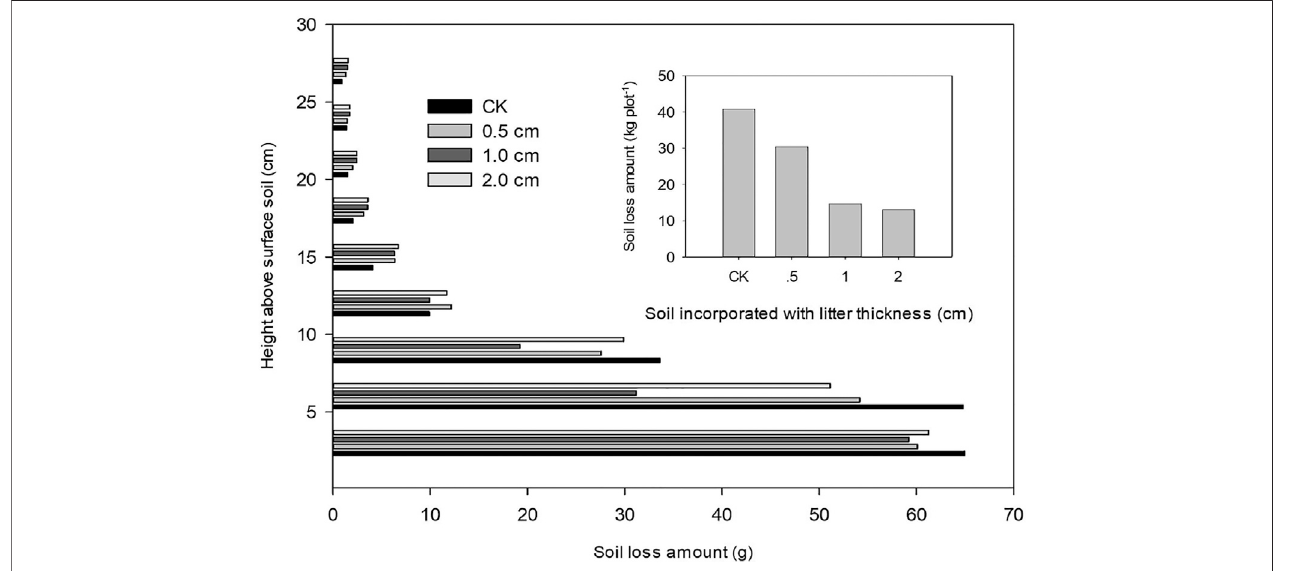
FIGURE 4 | Soil loss amount under soil incorporated with different residual